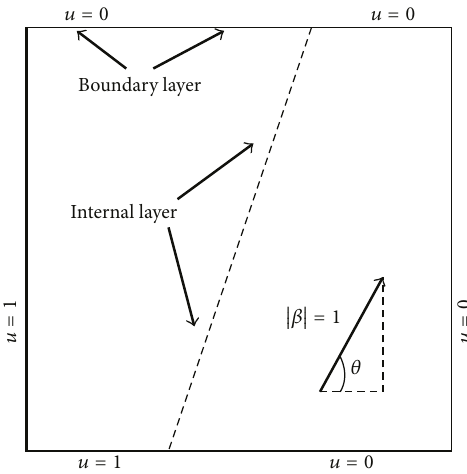
Figure 9: Configuration of Experiment